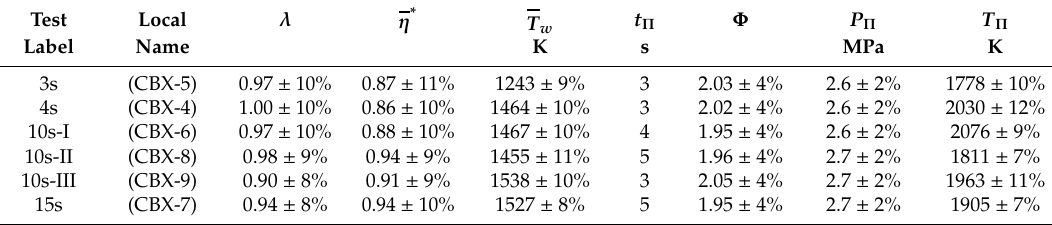
Table 2. Summary of tier II (NTRT + ) and tier III (TTRT) results.